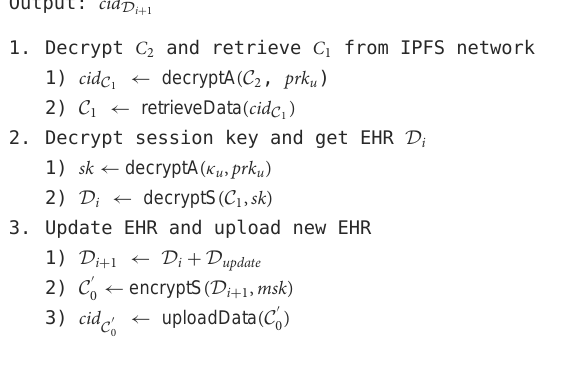
Algorithm 1. Creating and updating health records in Hyperledger